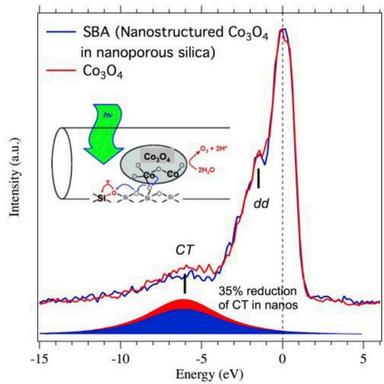
RIXS spectra of Co3O4 microcrystalline powder and nanostructured Co3O4 in nanoporous silica (SBA15).